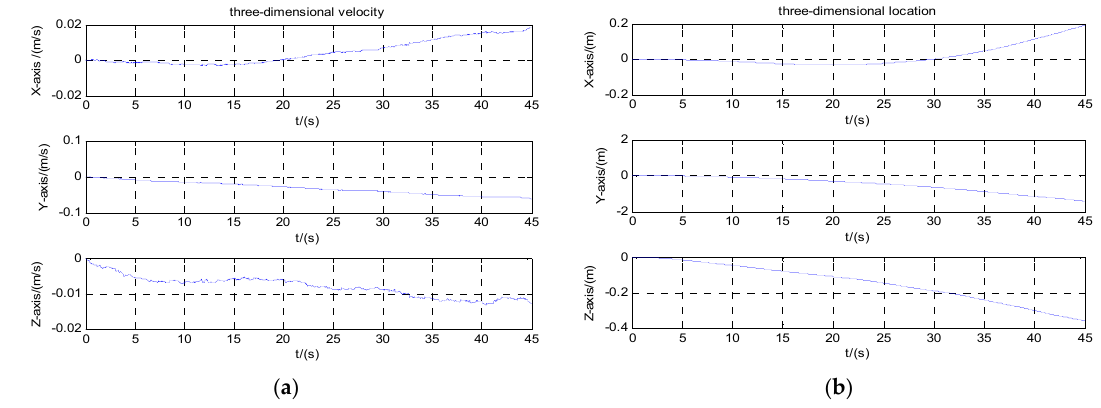
Figure 7. Velocity and position after compensation: ( a ) velocity; ( b ) position.